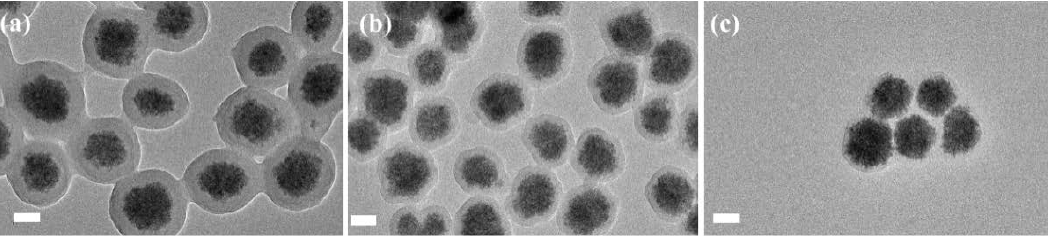
Figure 6. TEM images of ( a ) MSP@PNAMAm- p - co -PNIPAm; ( b ) MSP@PNAMAm- p - co -PAA; ( c ) Figure 6. MSP@PNAMAm- p - co -HEMA. The scale bar is 100 nm.